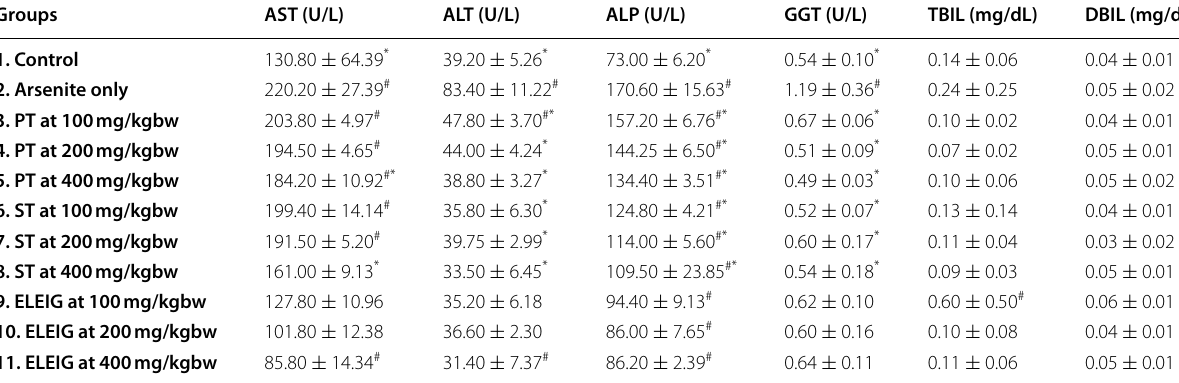
Data are expressed as mean SD ( n 5); # p ˂ 0.05 compared with group 1; * p ˂ 0.05 compared with group 2; ELEIG E thanol leaf extract of Irvingia gabonensis ; mg / ± = kgbw Milligram per kilogram body weight, PT P ost-treatment, ST S imultaneous treatment.